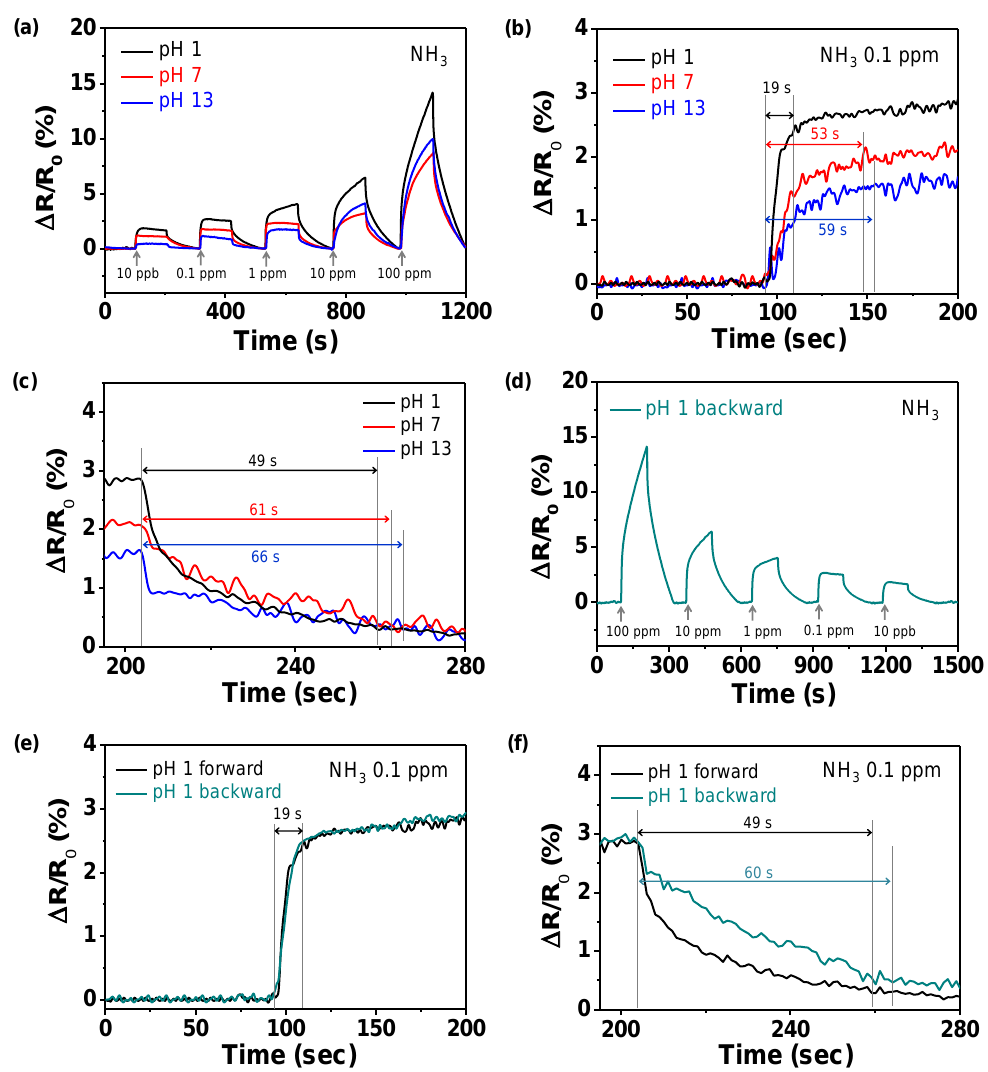
Figure 7. Reversible and reproducible responses are measured at a constant current (10 −6 A) for PPy-based electrodes. ( a ) Normalized resistance changes upon sequential exposure to increasing concentrations of NH 3 at different pH values. ( b ) Response and ( c ) recovery times of PPyNPs toward 0.1 ppm of NH 3 at different pH values. ( d ) Normalized resistance changes of pH 1 based-electrode upon sequential exposure to decrease concentrations of NH 3 . ( e ) Response and ( f ) recovery times of pH 1 based-electrode toward 0.1 ppm of NH 3 , depending on the direction of increase (black) and decrease (green) in concentration of NH 3 .